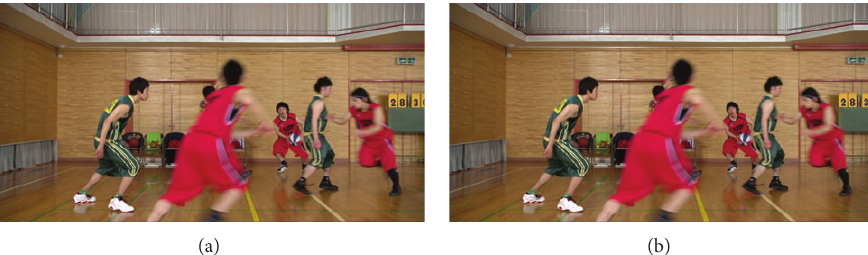
Figure 7: Class B (BasketballDrive-QP 22, the 75th frame): (a) the original picture and (b) the decoded picture by the proposed